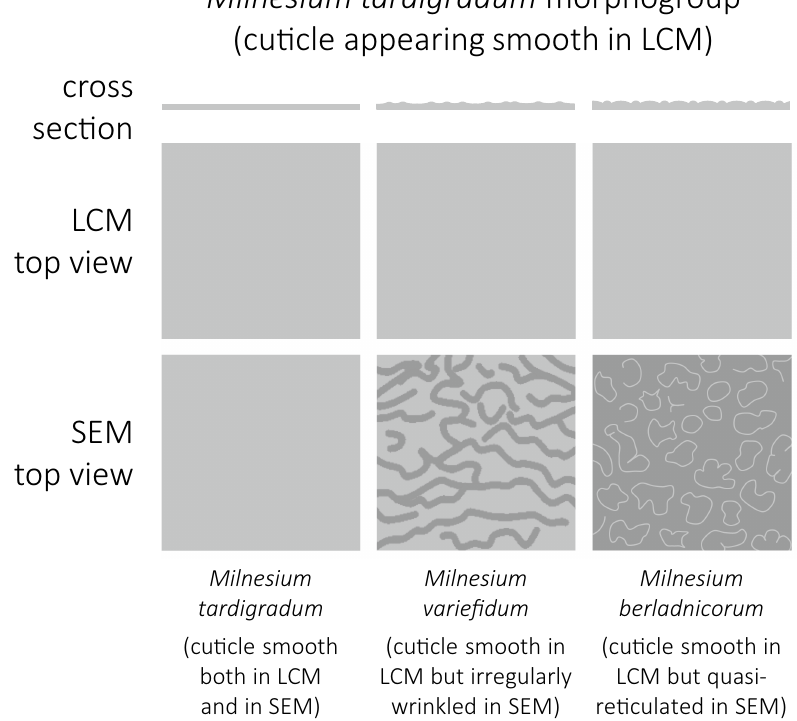
Figure 6. Schematic drawings showing a different appearance of “smooth” cuticle in the Milnesium tardigradum morphogroup under LCM (top panel) and SEM (bottom panel). Whereas cuticle is truly smooth in M tardigradum (left panel), it exhibits fine irregular wrinkles M. variefidum (middle panel) and an irregular quasi- reticulum with small bumps in M. berladnicorum (right panel) that are below LCM